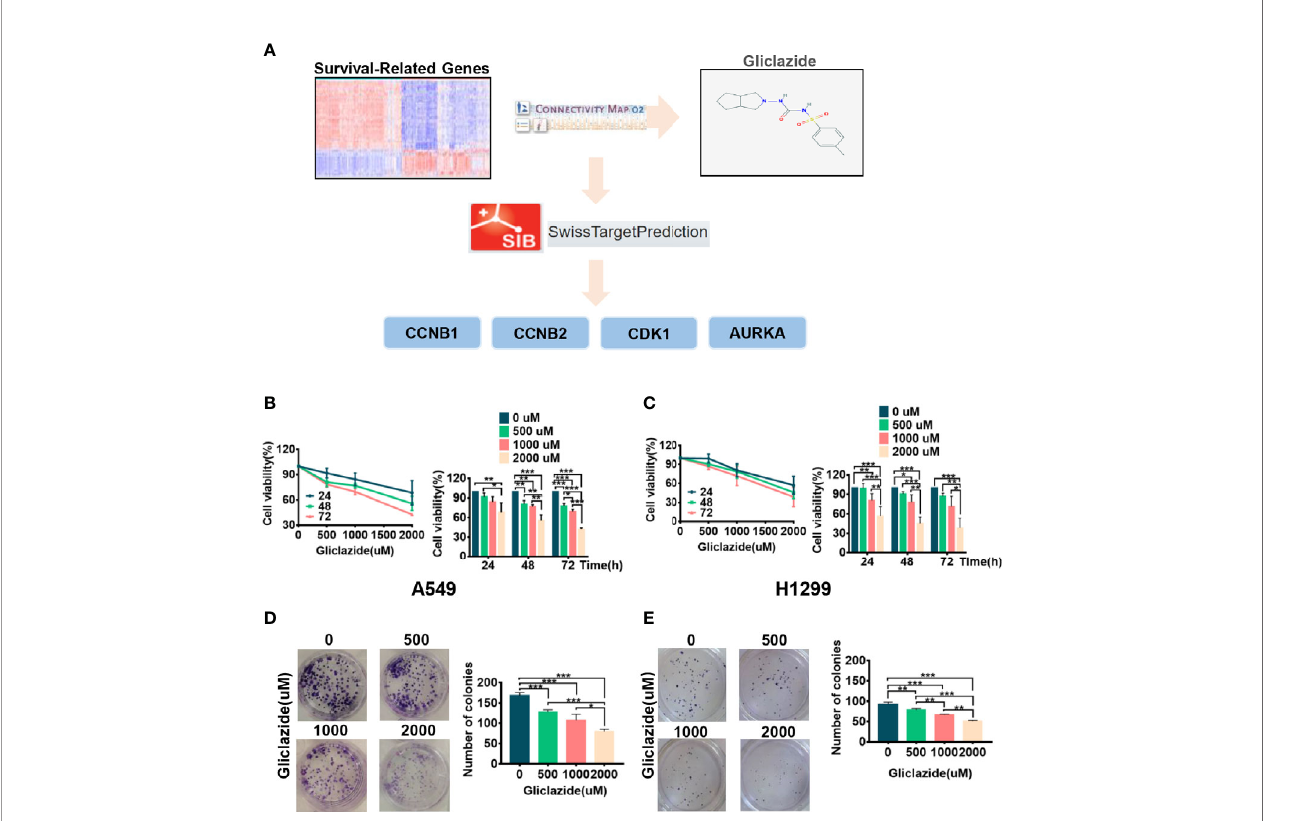
FIGURE 6 | The screening process and proliferation experiment veri fi cation of gliclazide. (A) The methodology used in the compilation of survival-differentially expressed genes and the CMAP algorithm. (B – E) A549 and H1299 cells were treated with gliclazide for 24, 48 and 72 h and the cell viability was measured by MTT Assay (B , C) , or colony-forming assay (D , E) . One-way ANOVA was used for statistical analyses. Data are plotted as mean ± SD. P values are labeled in the fi gures. *P < 0.05; **P < 0.01; ***P <